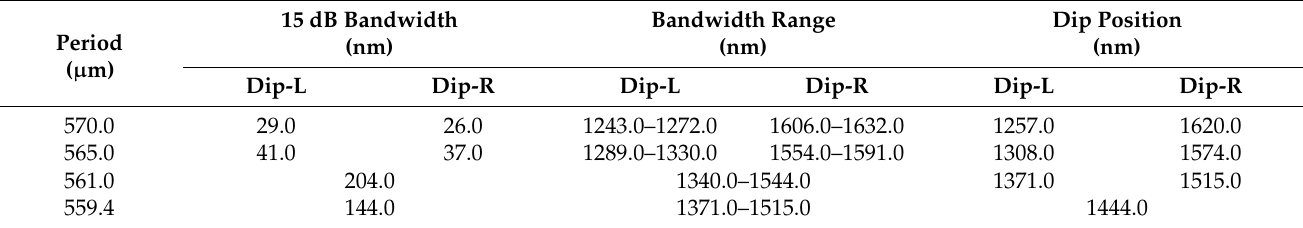
Table 2. Characteristic parameters of simulated spectra corresponding to different periods of the LPFG. Period ( µ